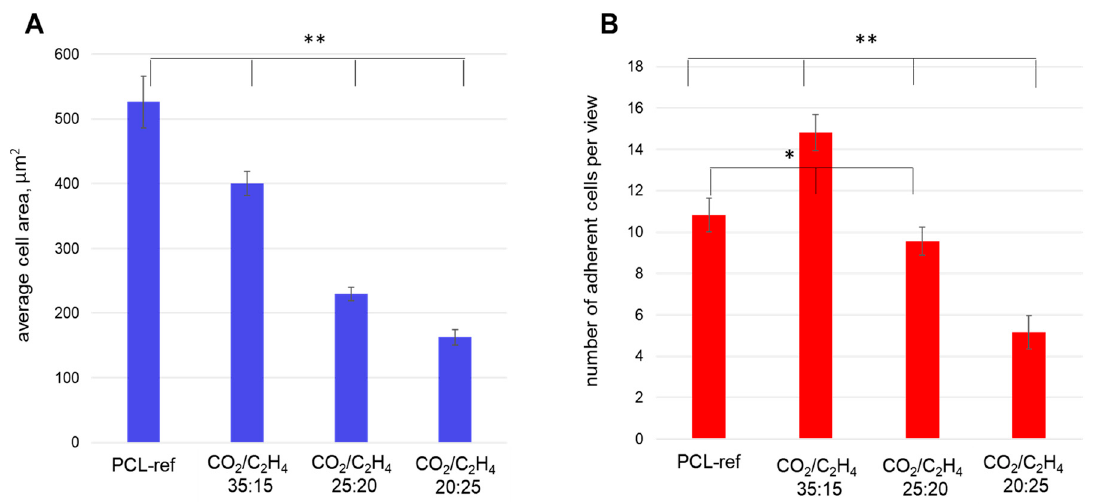
Figure 9. The average areas of MSCs ( A ) and number of adherent cells ( B ) measured on different samples: PCL-ref (untreated nanofibers), nanofibers coated by Ar/CO 2 /C 2 H 4 plasma polymers at a CO 2 :C 2 H 4 ratios of 35:15, 25:20, and 20:25. The adhesion of cells was assessed by cell area by phalloidin staining of cell actin filamentsafter 20 min (short-time adhesion). Hoechst staining of the cell nucleus determined the number of cells. ** p ≤ 0.1, * p ≤ 0.5.